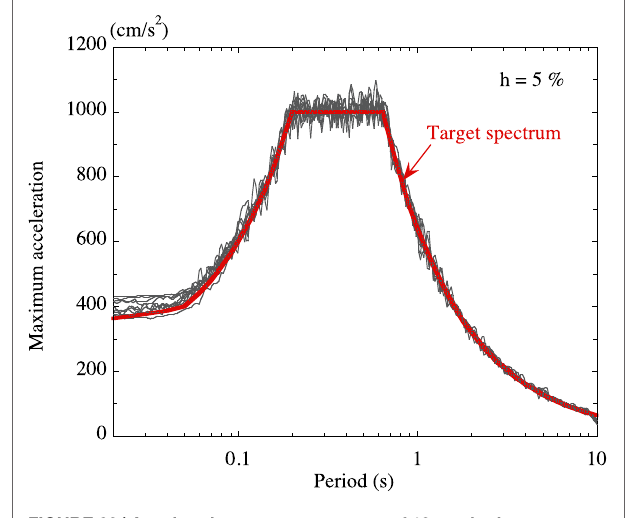
FIGURE 20 | Acceleration response spectra of 10 synthetic earthquakes with the target spectrum